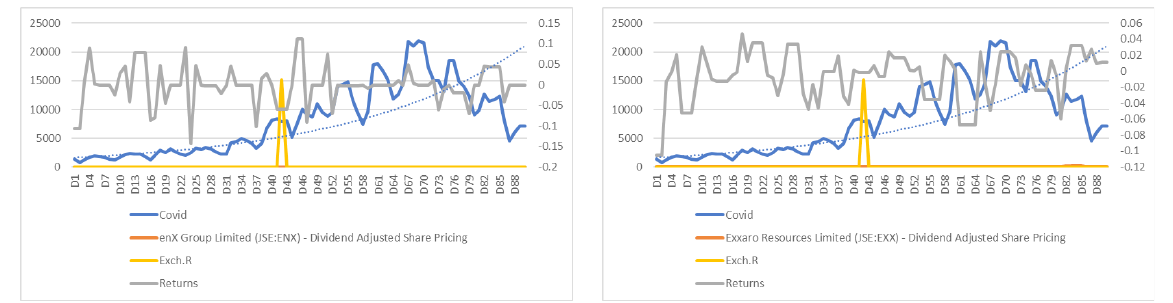
Figure 5. De Exxaro Resources Limited Figure 6. Enx Group